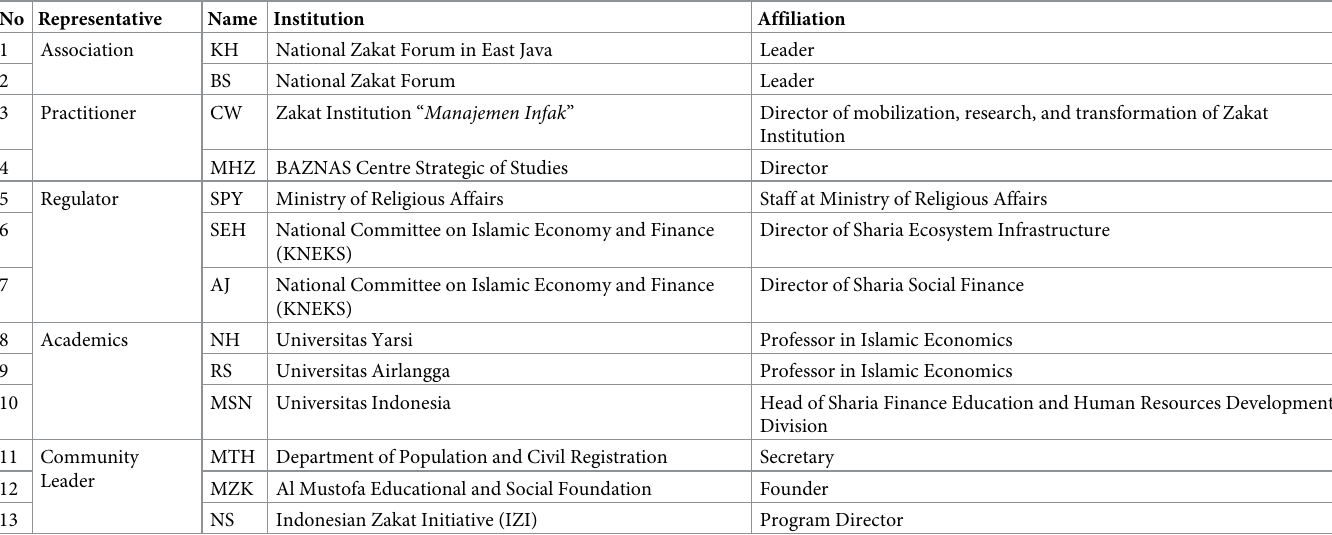
Table 2. List of research respondents.